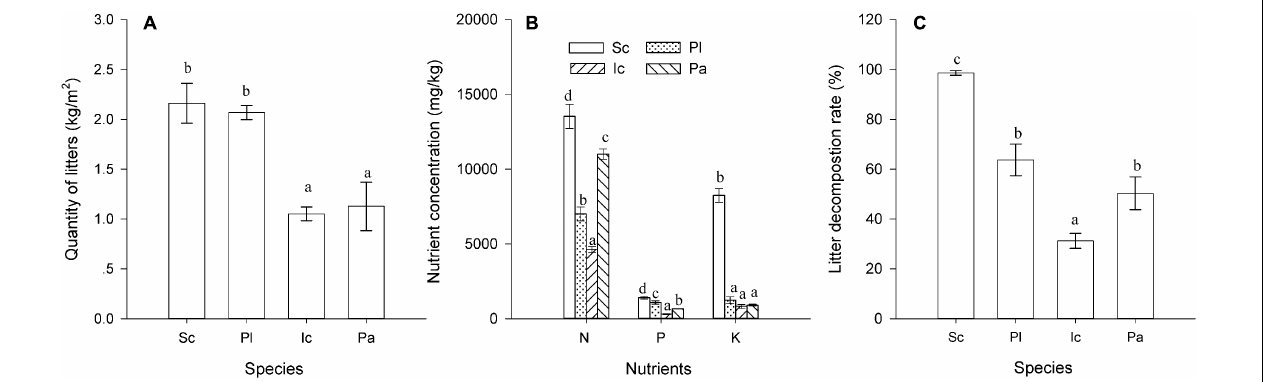
FIGURE 3 | Litter quantity, nutrient concentration and decomposition rate of the species. (A) Leaf and stem litter mass (g); (B) Nutrient (N, P, and K) concentrations (mg/kg), and (C) Decomposition rate (the ratio of decomposed litter to the original litter mass, %). Sc, Pl, Ic, and Pa stand for S. canadensis , P. latifolius , I. cylindrical , and P. australis, respectively. Bars and vertical lines are means ± SE. Different letters indicate significant differences between the species ( P = 0.05).